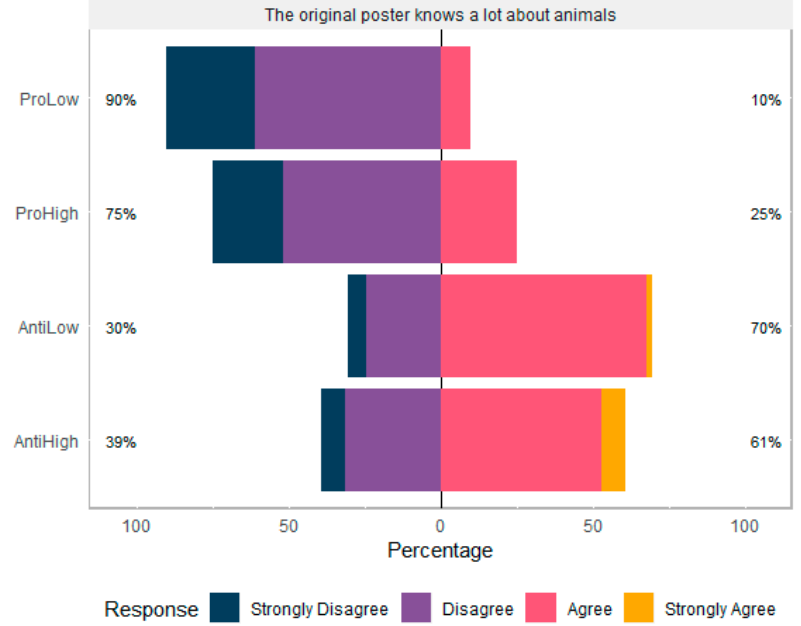
Figure 3. Participants’ (N = 211) agreement with the statement “The original poster knows a lot about animals”. about